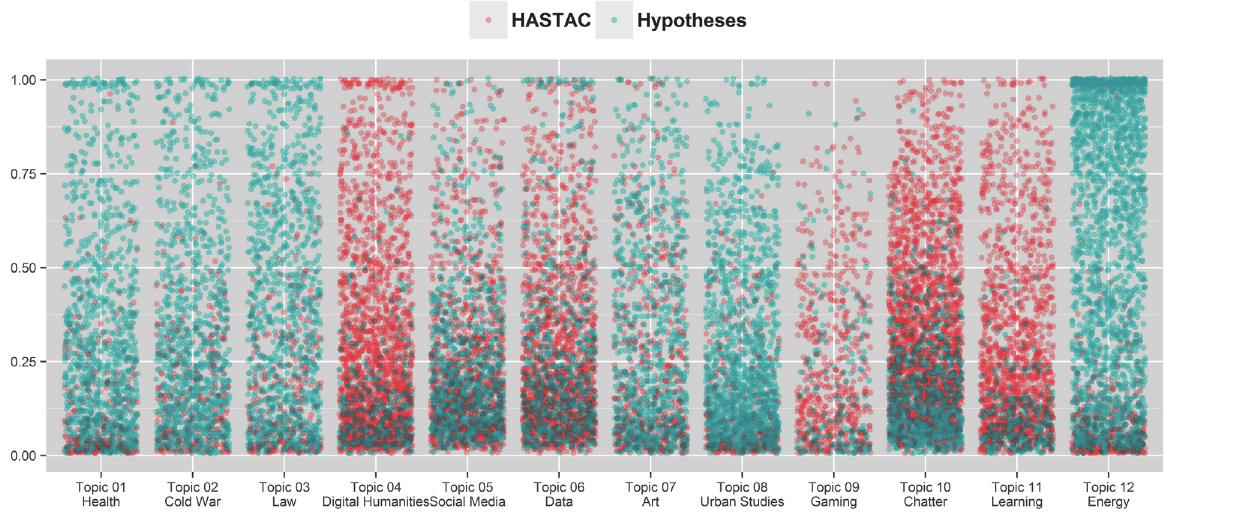
Fig 4. Distribution of posts per topic, with posts in red from HASTAC and posts in blue from Hypotheses.